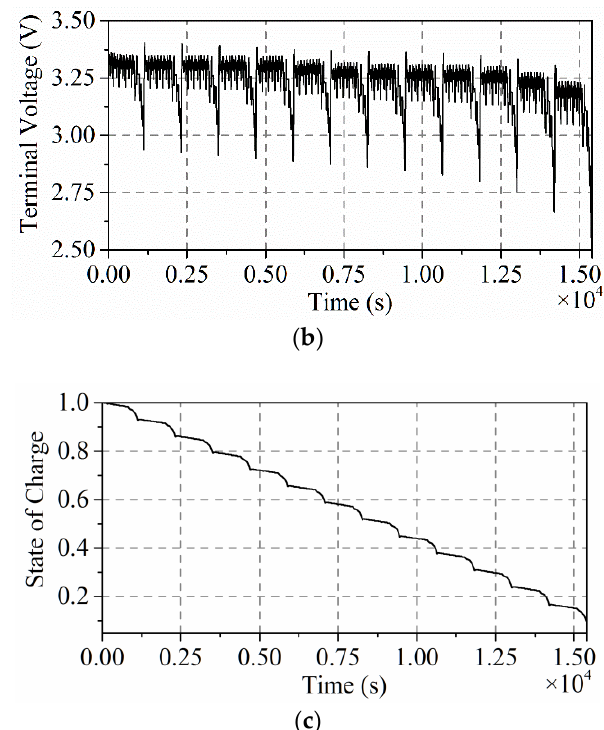
Figure 6. Measurement during multi-NEDC driving cycles. ( a ) Current; ( b ) voltage; ( c ) SOC.